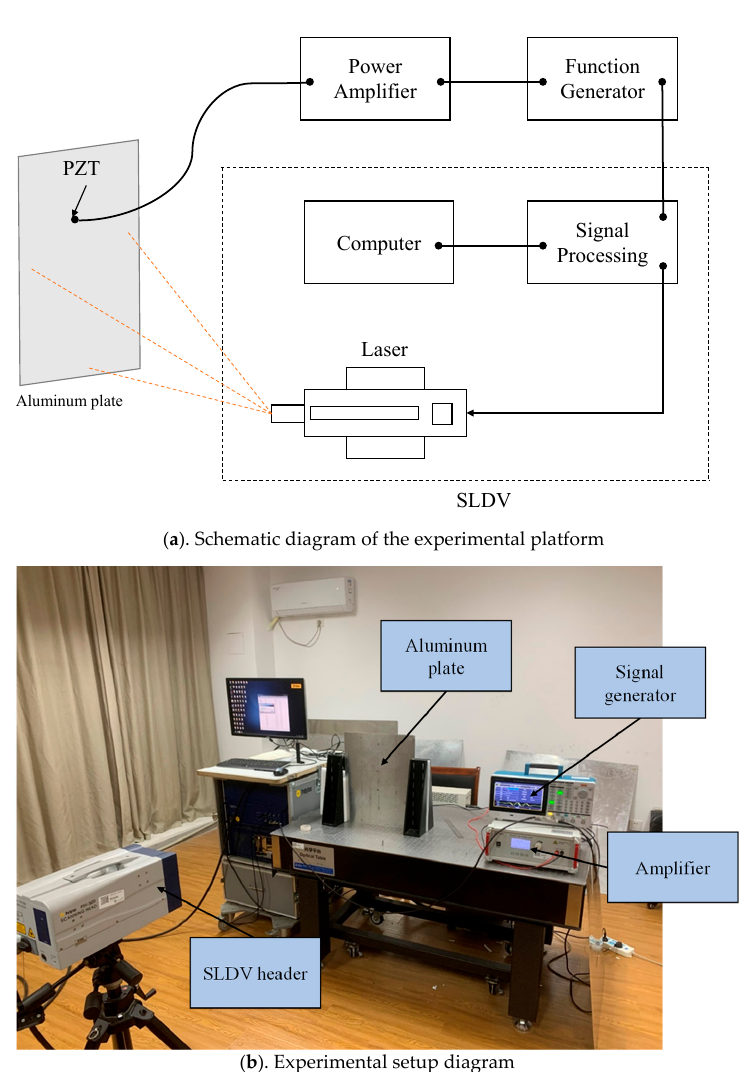
Figure 17. Experimental platform.